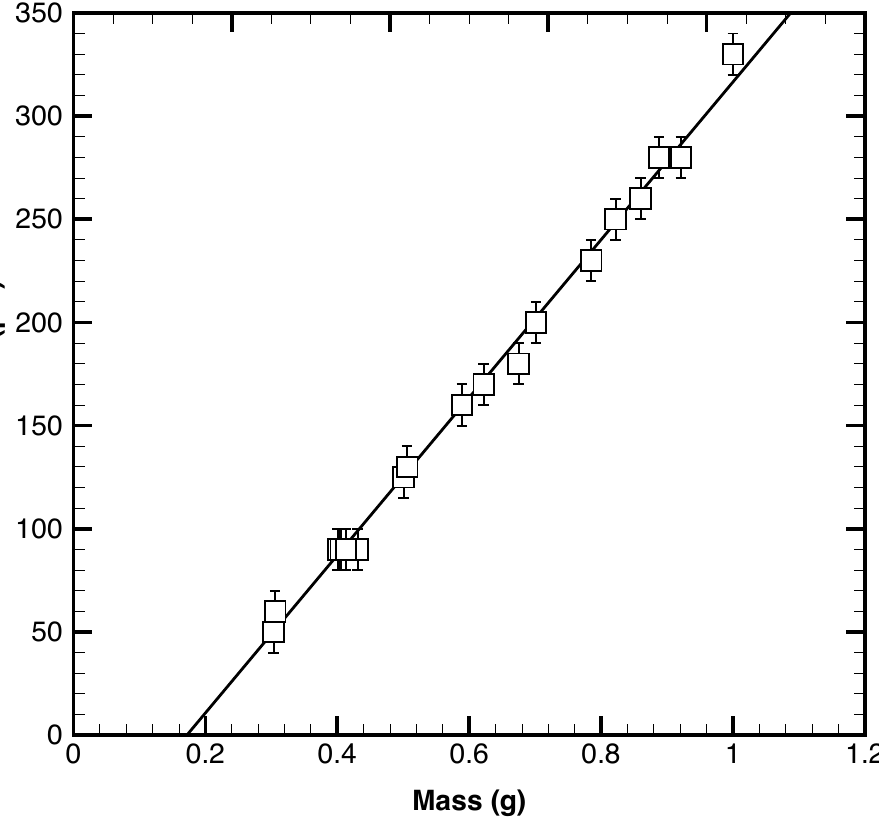
Figure 7. Maximum decomposition pressure, as a function of mass of blowing agent. Data taken from the pressure vessel test. The straight line represents the best fit for the testing samples with mass less than 1 g, with a coefficient of determination R 2 =